Question: Author a descriptive caption for the visualization shown.
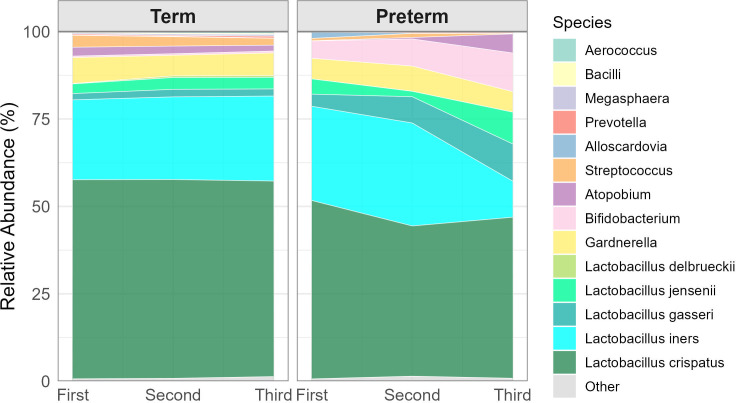
Answer: Stacked area graphs of vaginal community composition across three trimesters. Relative abundance of major bacterial genera across trimesters for the entire cohort. The x -axis shows trimesters (first, second, third), and the y -axis shows relative abundance (0%–100%). Term controls typically maintain stable dominance of a single Lactobacillus species (predominantly L. crispatus or L. iners ) throughout pregnancy. sPTB cases frequently exhibit shifts between Lactobacillus dominance and communities with increased abundance of Gardnerella , Atopobium , or other anaerobic taxa, often with multiple transitions across trimesters.